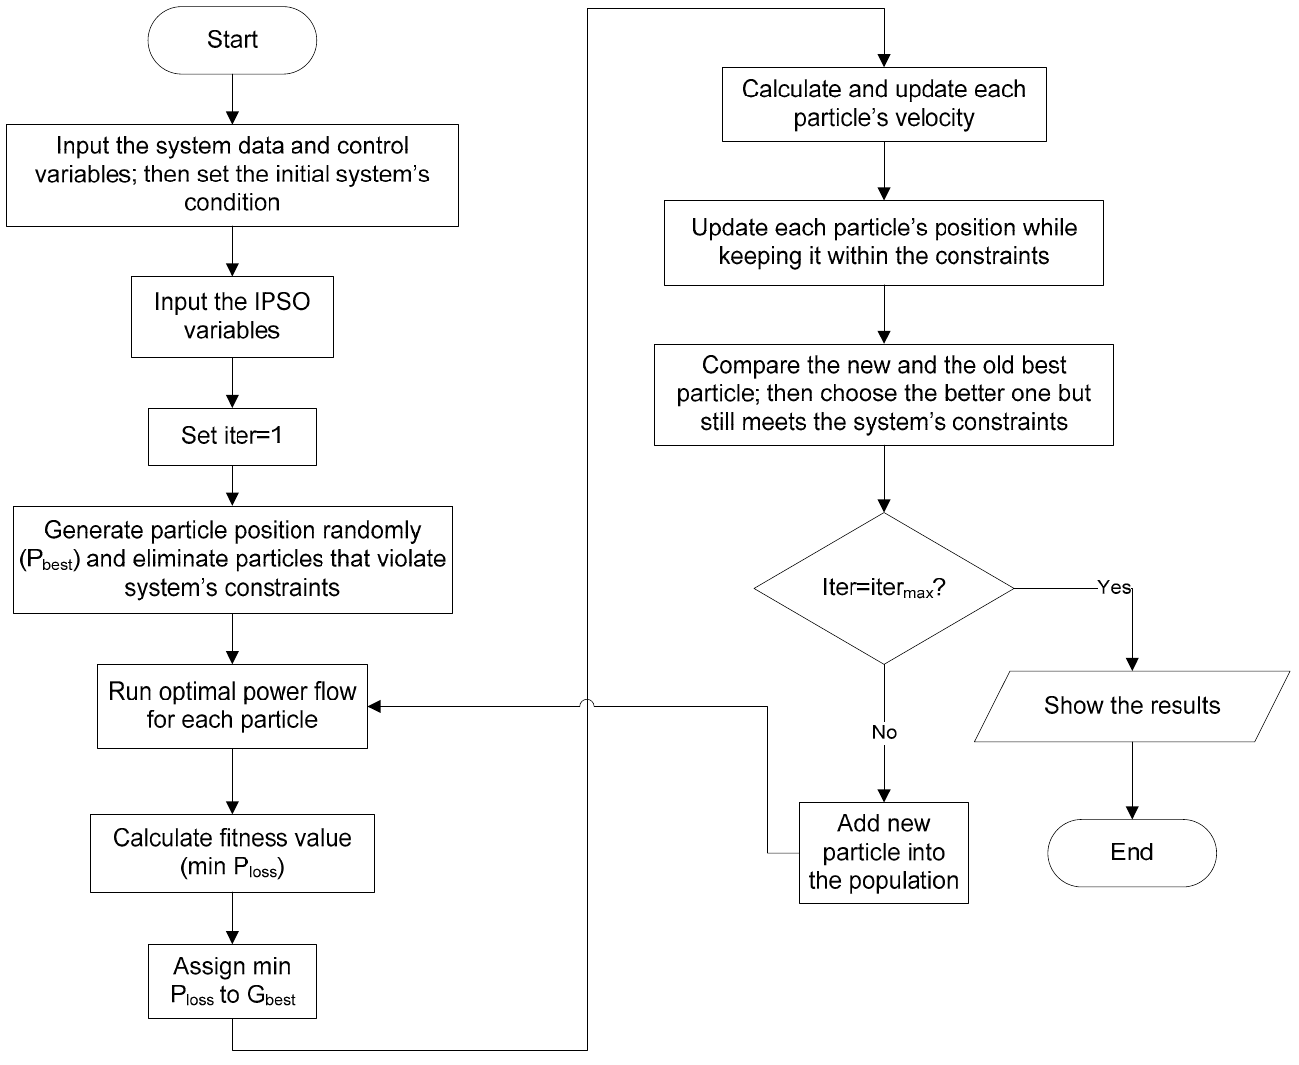
Figure 1. Flowchart of the optimal power flow based on incremental particle swarm optimization.